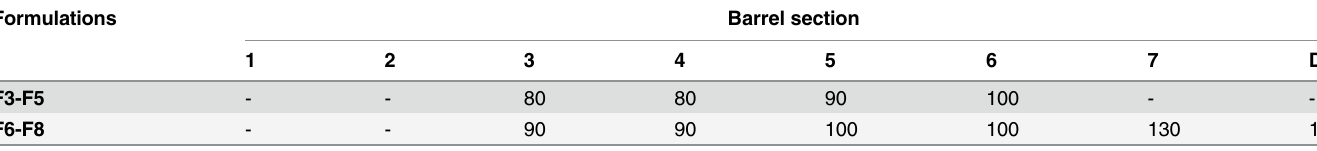
Table 2. Temperature (°C) profile in the barrel sections of the hot-melting extruder.